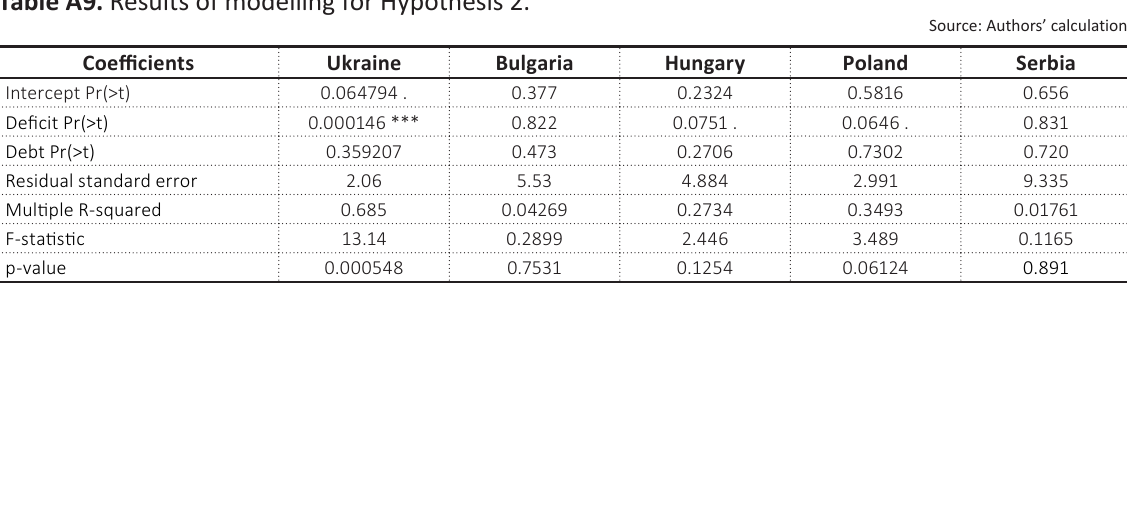
Table A9. Results of modelling for Hypothesis